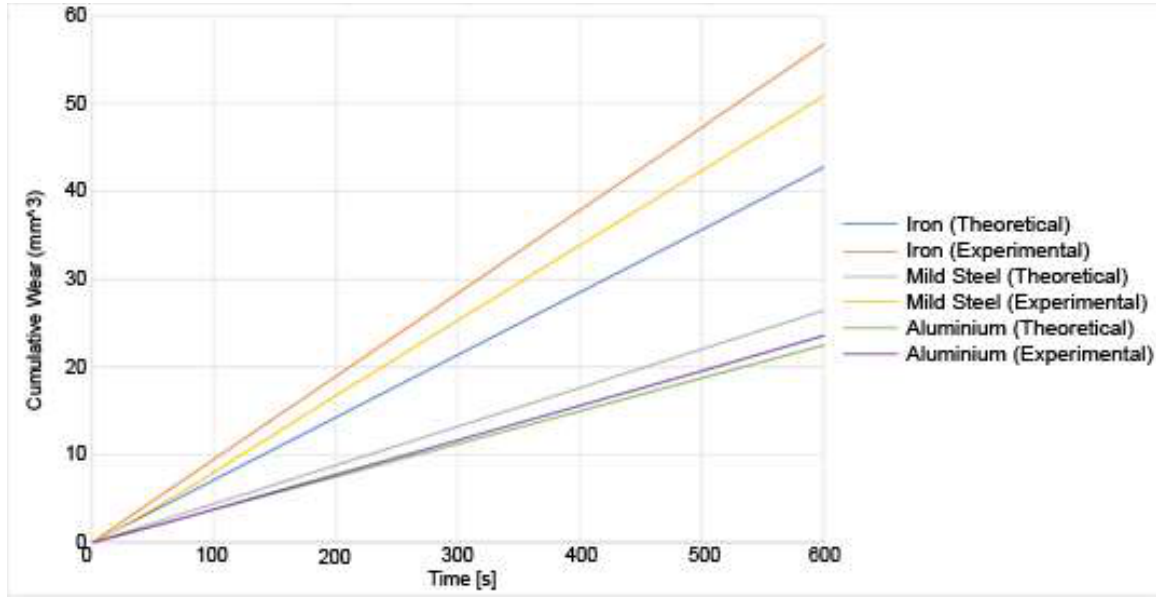
Figure 14. Experimental and theoretical results for the wear of varied materials under a 20 N load.